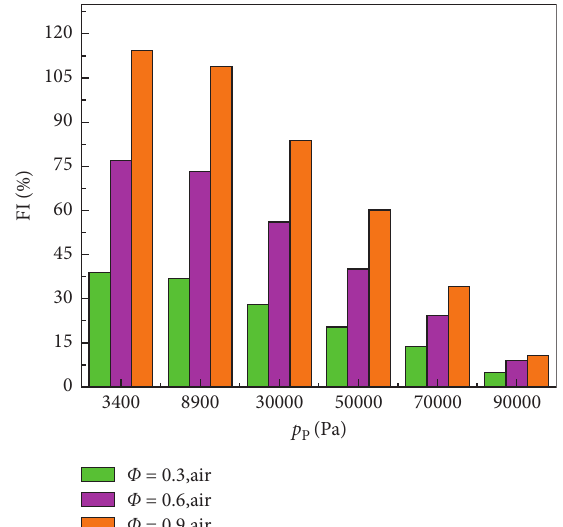
Figure 7: Flux improvement efficiency of air bubbling process under different effective enhancement area coefficients ( Φ ) and different pressure of the permeate side. T F,in � 323K, T P,in � 298K, V F,in � 0.145m/s, V P,in � 0.002m/s, P F � P 0 , W NaCl � 0.